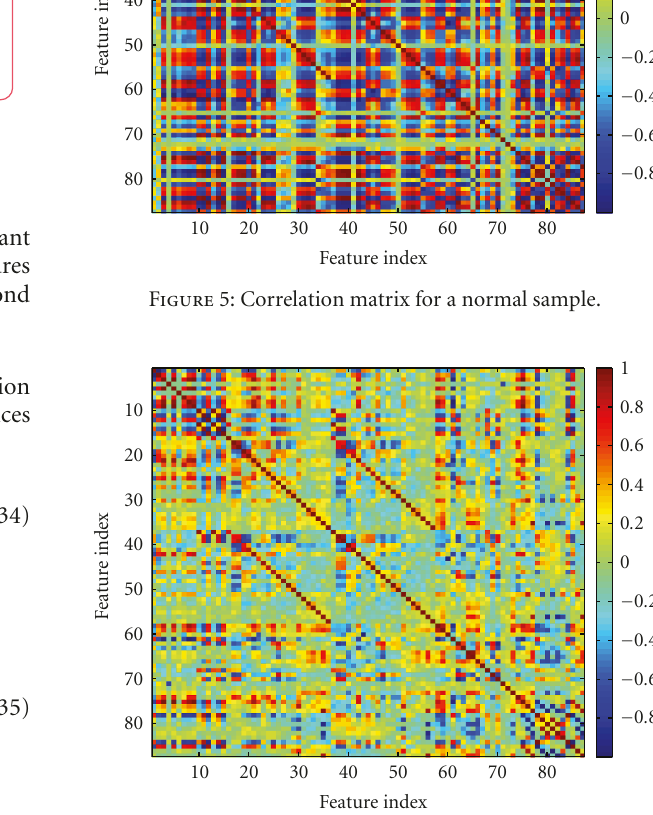
Figure 6: Correlation matrix for a pathological